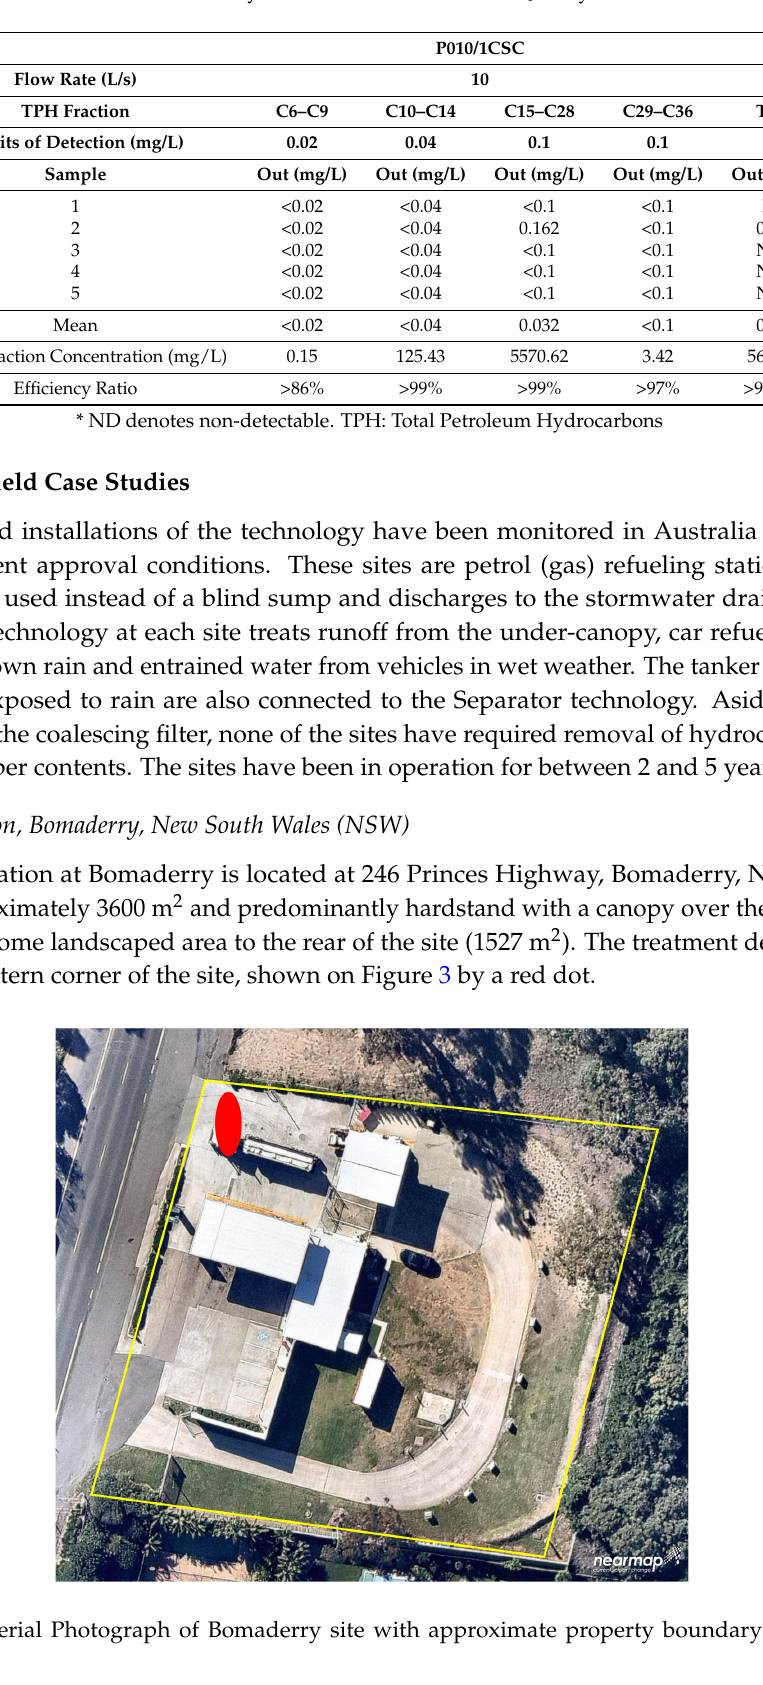
Table 2. University of South Australia Water Quality Results.